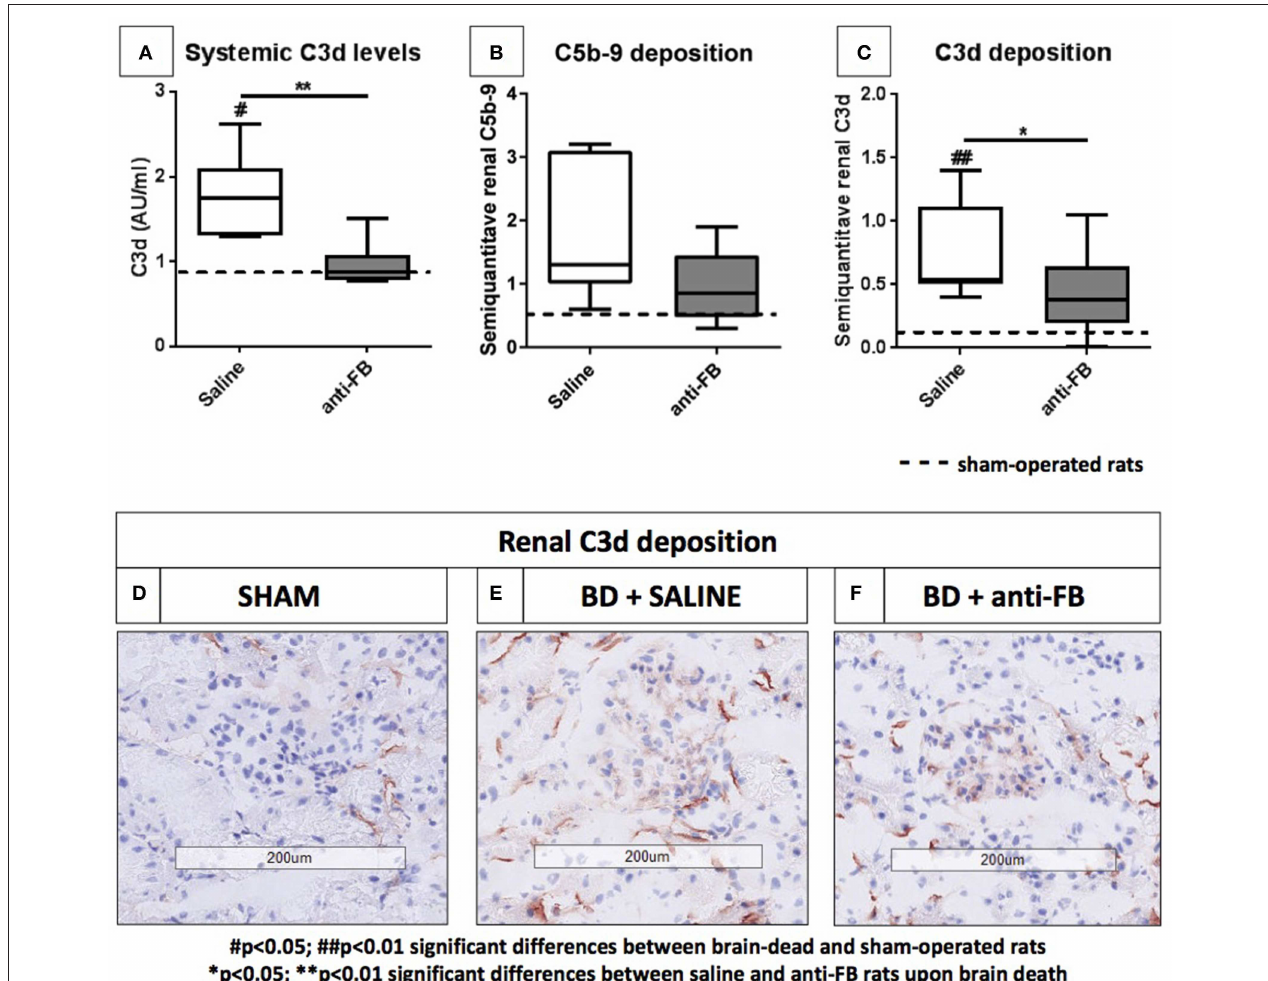
FIGURE 2 | Systemic and local complement levels after 4h of brain death. (A) Systemic C3d levels of brain-dead rats treated with saline or anti-factor B. Plasma C3d levels were determined after 4h of brain death. C3d was captured by using a monoclonal mouse anti-C3 antibody, detected with a rabbit anti-human C3d antibody and goat anti-rabbit-HRP. (B) Renal C5b-9 deposition and (C) renal C3d deposition in frozen sections from (D) sham-operated rats, (E) saline-treated rats, and (F) anti-factor B treated rats after 4h of brain death. Data are shown as median ± IQR. Data were analyzed by Mann Whitney- U -test and Bonferroni post-hoc test, asterisks above the bars denote significant differences between the brain-dead rats (* p < 0.05, ** p < 0.01, and *** p < 0.001). The dashed line represents the mean of the sham-operated rats. # Significant differences between the brain-dead rats vs. sham-operated rats ( # p < 0.05, ## p < 0.01, and ### p < 0.001). Anti-FB, anti-factor